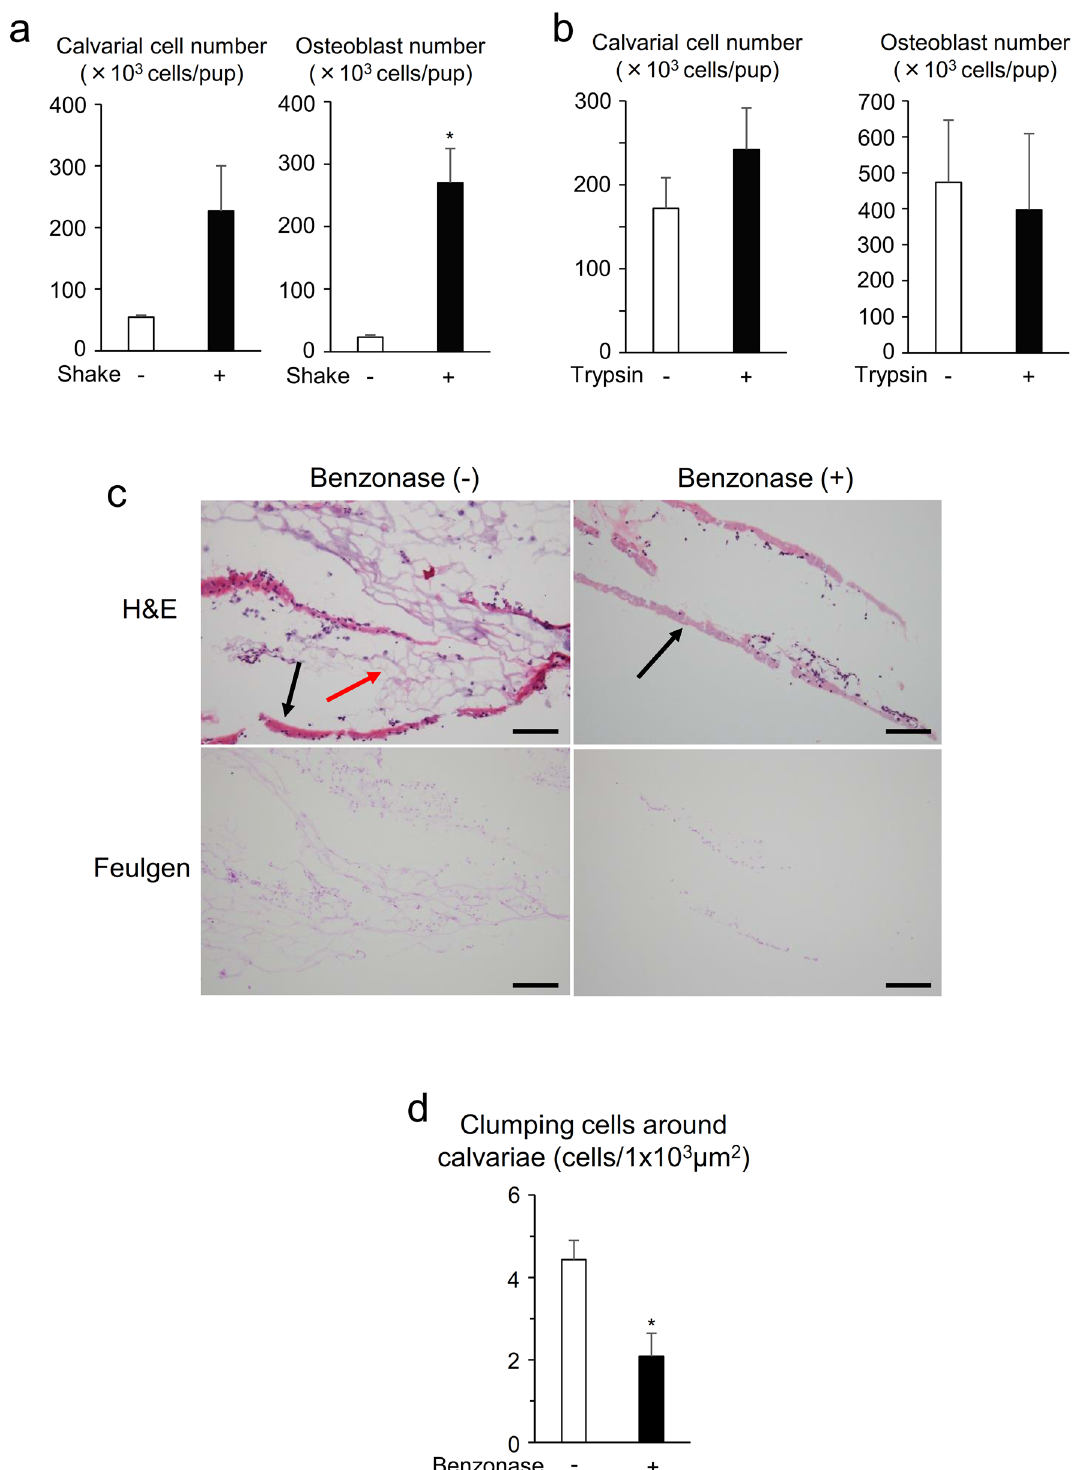
Figure 4. Benzonase shears nucleic acids and separates osteoblasts from digested viscous bones. ( a , b ) Neonatal calvariae were digested in the digestion solution supplemented with collagenase in the presence or absence of mechanical agitation in the shaking water bath ( a ) or trypsin ( b ). Digested calvarial cells were plated, expanded for 4–5 days, and collected as osteoblasts by trypsinization. Calvarial cells and osteoblasts from one pup’s calvaria were counted. ( c ) H&E (upper) and DNA Feulgen (lower) staining of newborn pups’ calvariae digested in the presence or absence of Benzonase. Black and red arrows indicate calvarial bones and connective tissues, respectively. Scale bars: 100 μm. ( d ) Histomorphometric analysis of osteoblast number per bone surface of calvariae in ( c ). n = 3. P values were determined by the unpaired t-test. Data are presented as means ± SEM. * P <